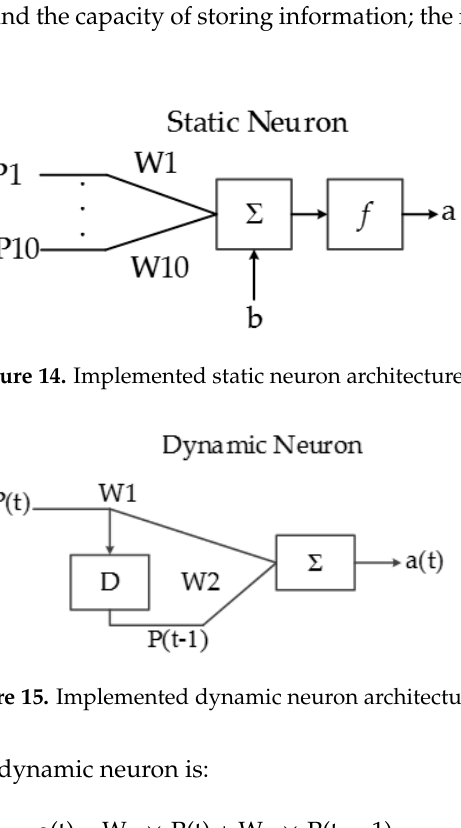
Figure 15. Implemented dynamic neuron architecture.